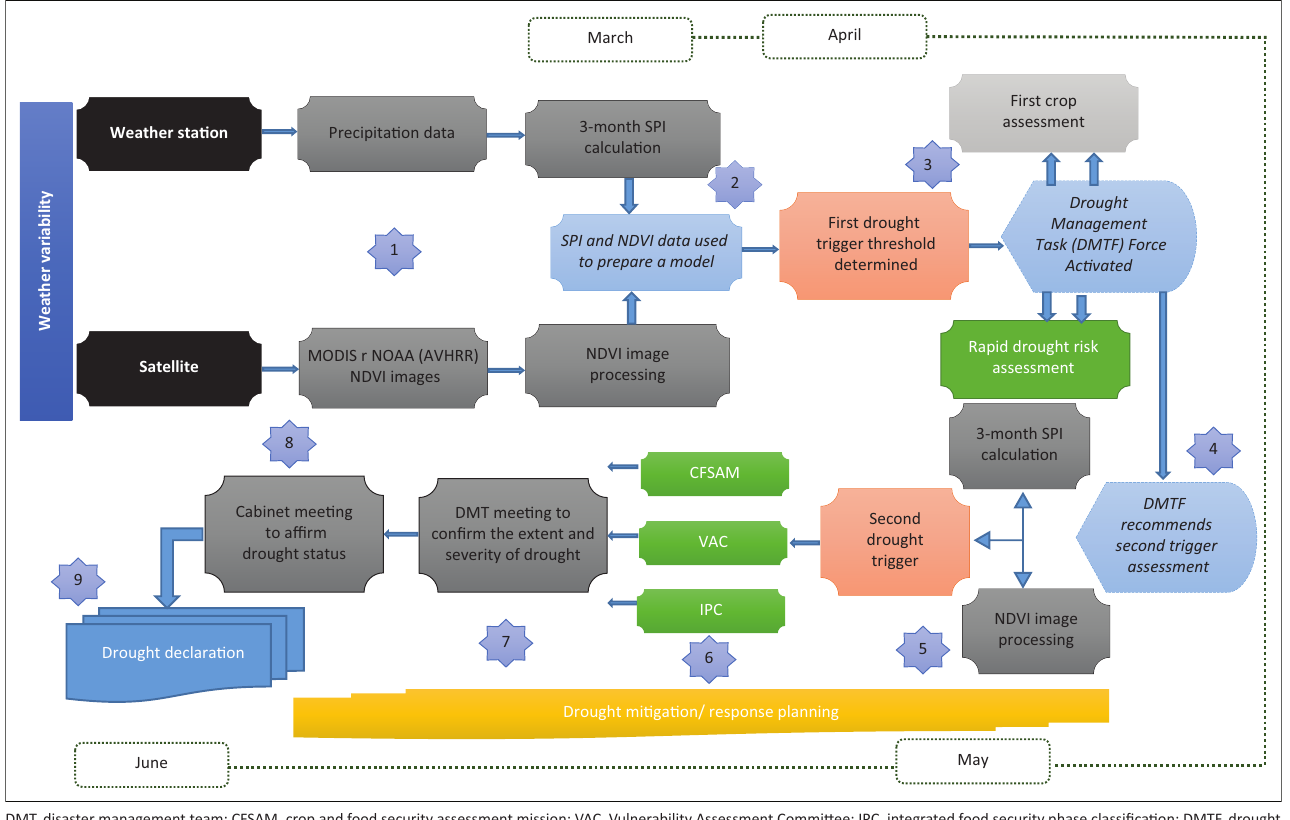
FIGURE 6: Drought monitoring and early warning